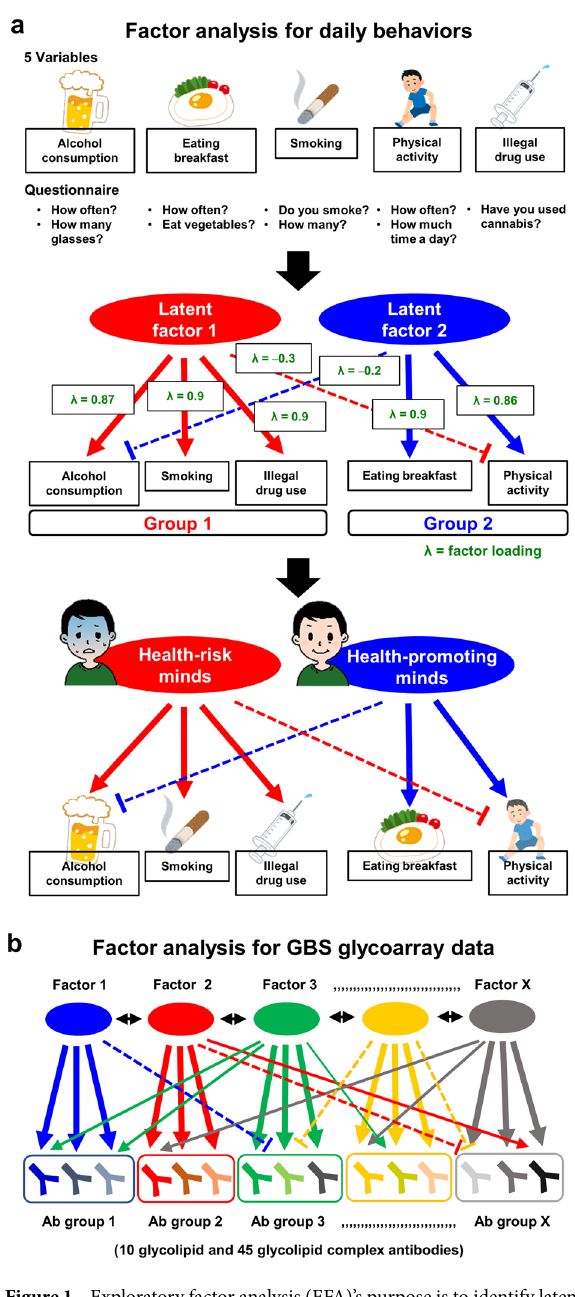
Figure 1. Exploratory factor analysis (EFA)’s purpose is to identify latent factors underlying a set of manifest variables; EFA is used when the research goal is to identify the nature and number of common factors among the variables. ( a ) An example of EFA in the psychology field to identify latent factors underlying daily behaviors. First, prepare a questionnaire listing the items (behaviors): alcohol consumption, eating breakfast, smoking, physical activity, and illegal drug use, asking questions such as how often one drinks alcohol, eats breakfast, or smokes. Based on big multiple data from many people, EFA of the questionnaire data results in grouping these variables (behaviors) and identifies the number of latent factors underlying the behaviors. Here, EFA clusters five behaviors into two groups (Groups 1 and 2) based on factor loading (λ ≥ 0.5, good association; and λ < 0, potential negative association), and extracts Latent factors 1 and 2. From the items (behaviors) in each group, the nature of Latent factors 1 and 2 are likely health-risk and health-promoting mindsets, respectively. ( b ) Hypothetical model of EFA using glycoarray data from patients with Guillain–Barré syndrome (GBS). In the current study, we hypothesized that several factors (Factors 1 to X), such as distinct microbial infection and autoantigen sensitization, may induce unique sets of antibody (Ab) groups (Ab groups 1 to X). If this is the case, EFA of the total 55 antibody data (10 anti-glycolipid and 45 anti-glycolipid complex antibodies) will determine the number (n = X) of factors as well as distinct sets of antibodies that are associated with each factor. By assessing the target antigens of glycolipid antibodies clustered into one group, we would estimate the nature of each factor; i.e., Ab group 1 is composed of three bluish antibodies, associating with the latent blue Factor 1. There can be associations between factors ( ↔ ) and positive ( → ) and negative (— ǀ ) associations of one factor to several Ab